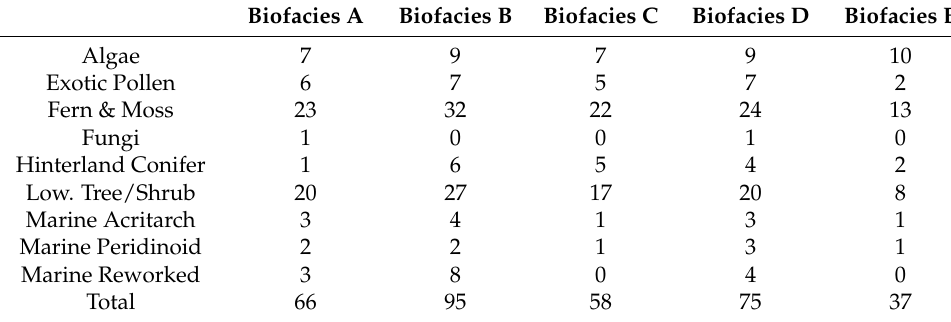
Table 5. Raw taxonomic richness (number of genera) in each